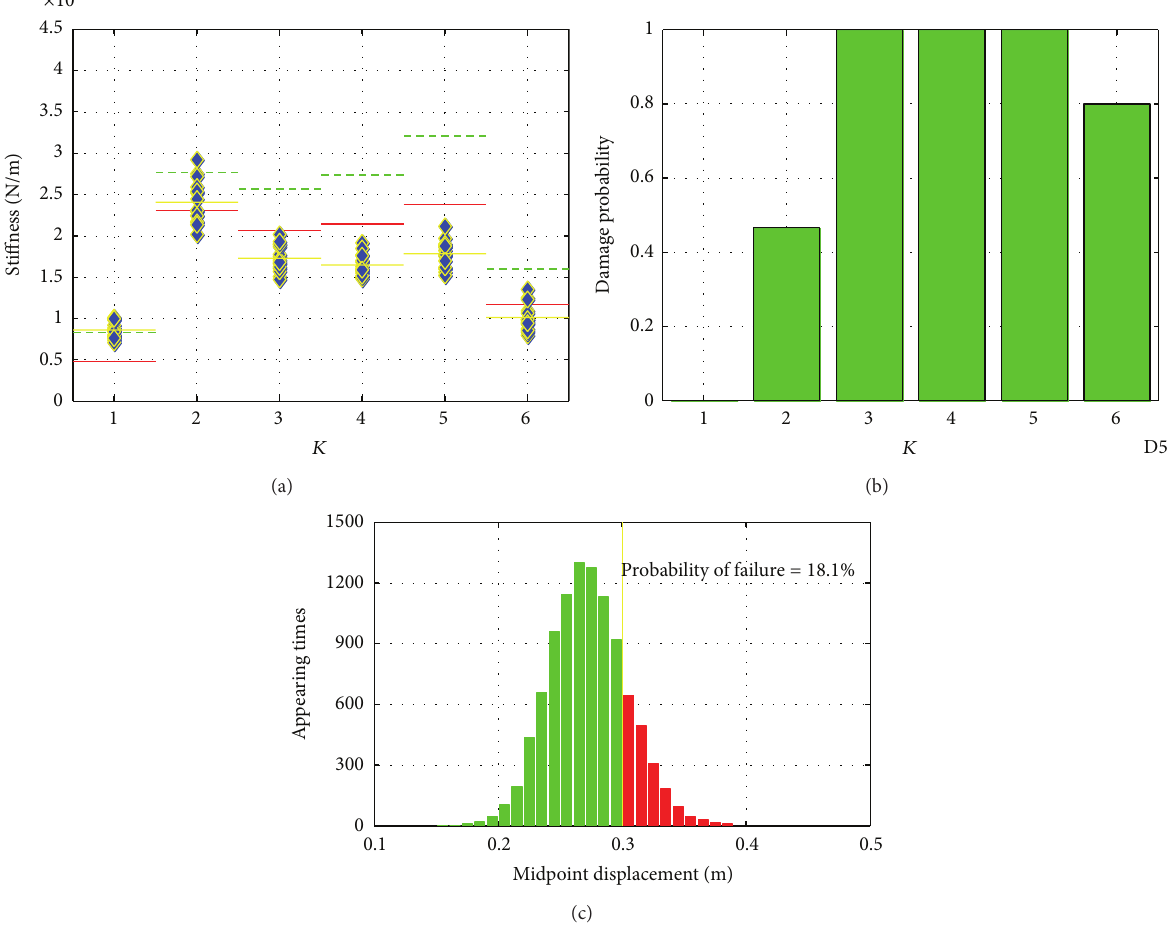
Figure 10: Results of damage scenario no.